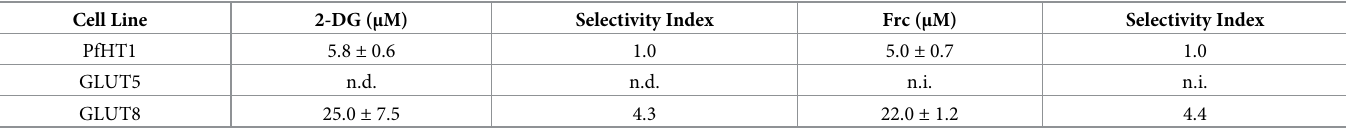
Table 2. IC 50 concentrations and selectivity indices for WU-1 in GLUT5 and GLUT8 overexpressing cells. Cell Line